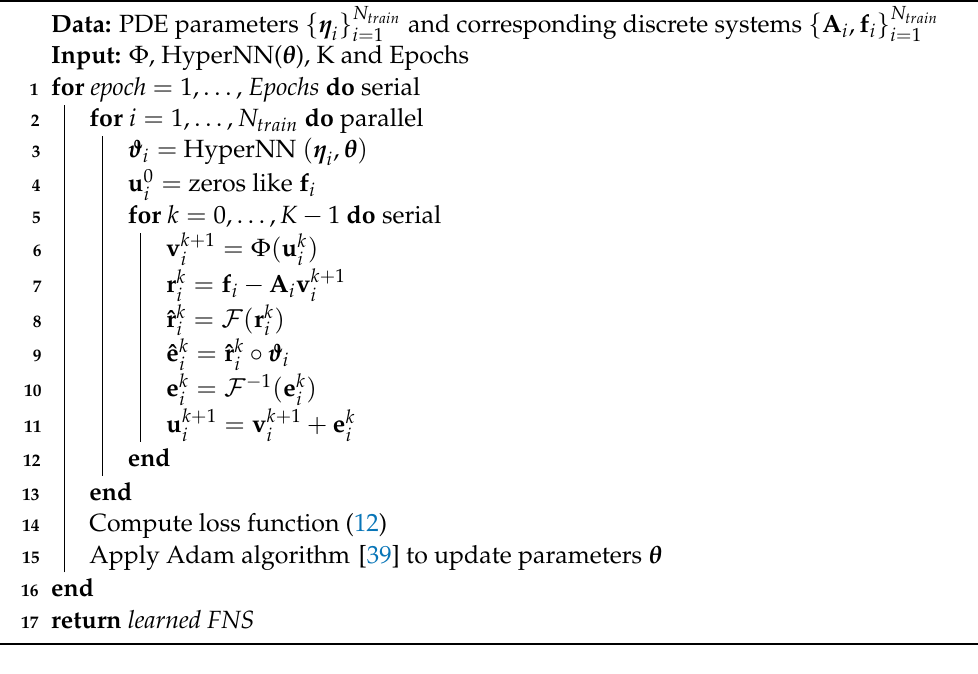
Algorithm 2: FNS online